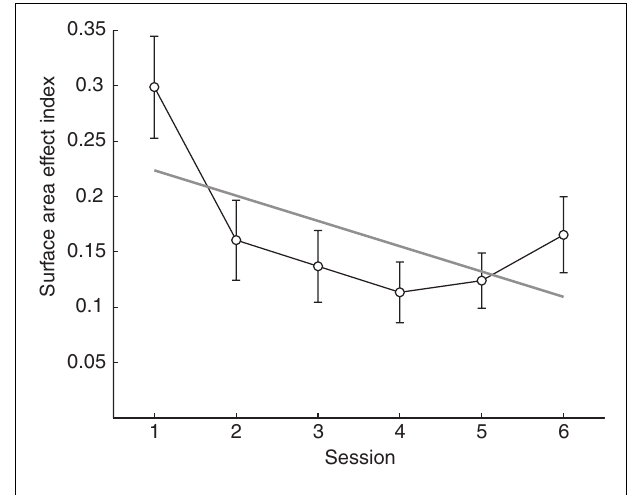
FIGURE 5 | Mean surface area effect index as a function of session number. The effect of surface area on accuracy decreased rapidly with the introduction of trial-by-trial feedback, plateaued after session 2, but remained low after feedback was removed on session 6. Gray line indicates the linear best fit accounting for repeated measures. Error bars indicate